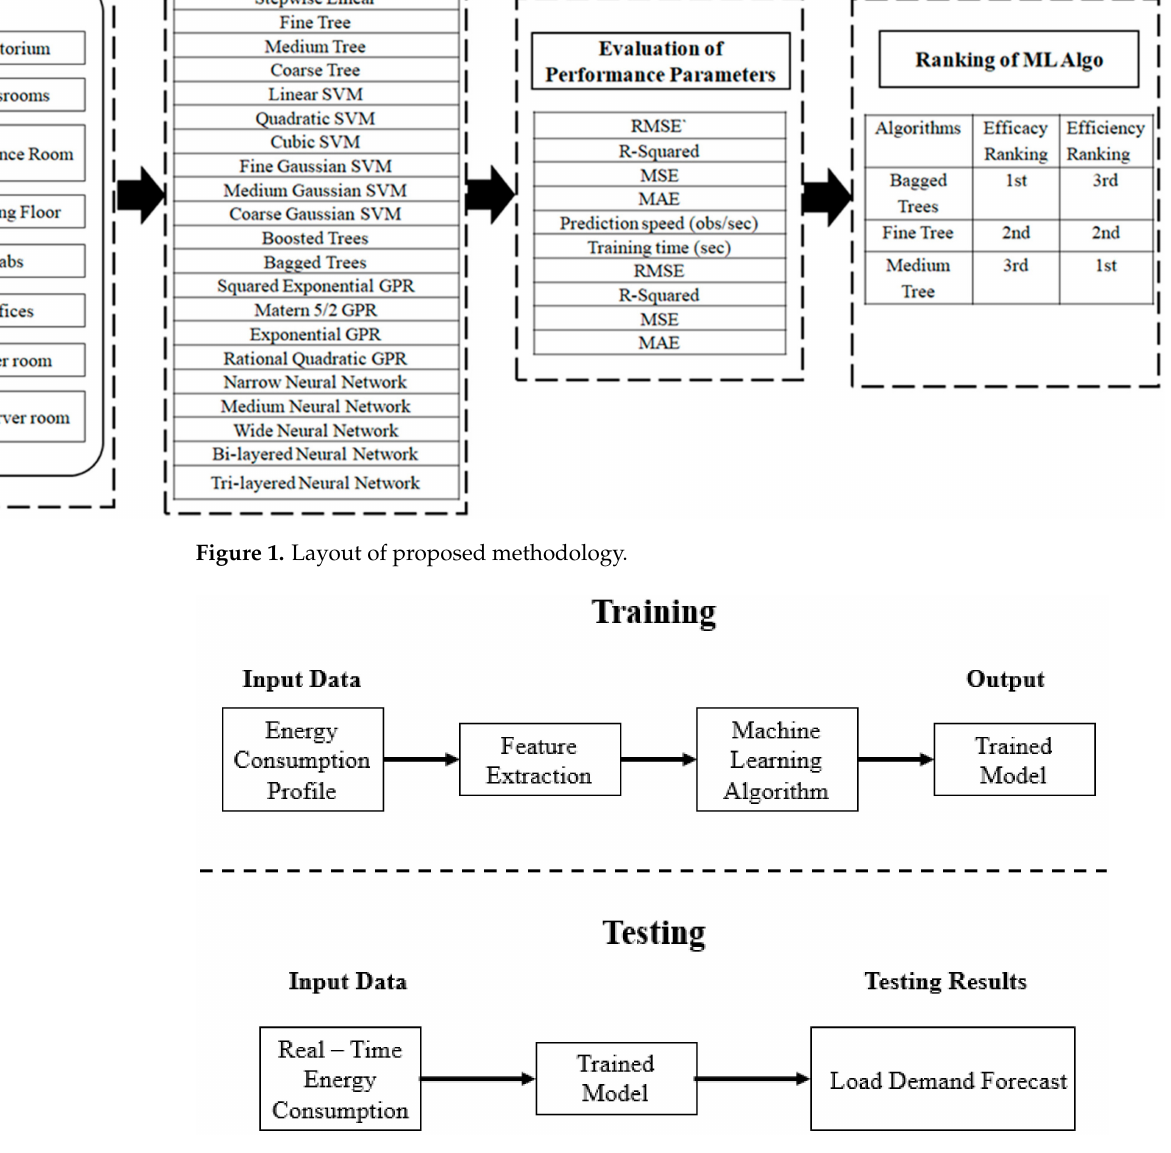
Figure 2. General framework of system training and testing